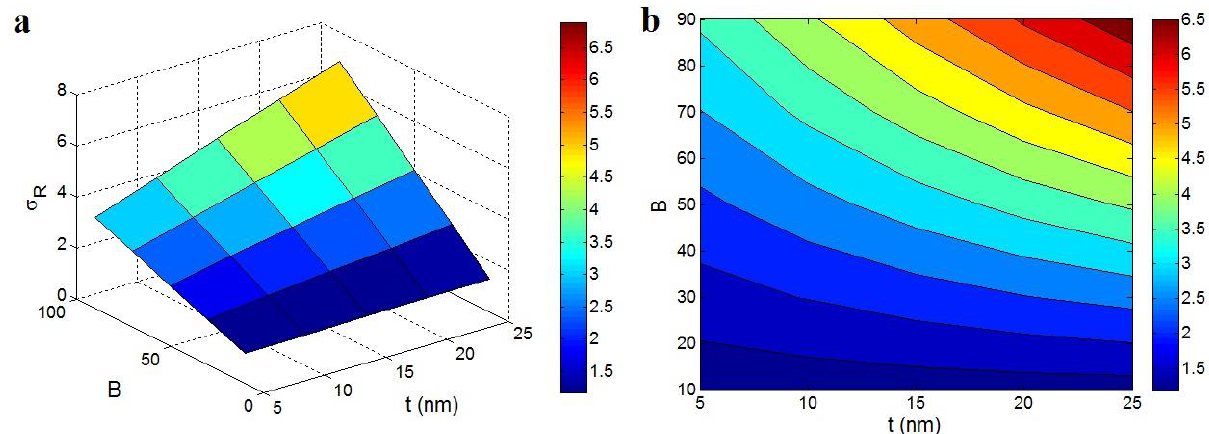
Figure 8. ( a ) The 3D and ( b ) contour plots of the relative strength in terms of t and B as determined using the advanced model at σ m = 40 MPa, ϕ f = 0.02, l = 10 µ m and R = 10 nm.